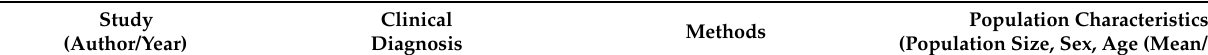
Table 1. Population characteristics in studies on salivary biomarkers for